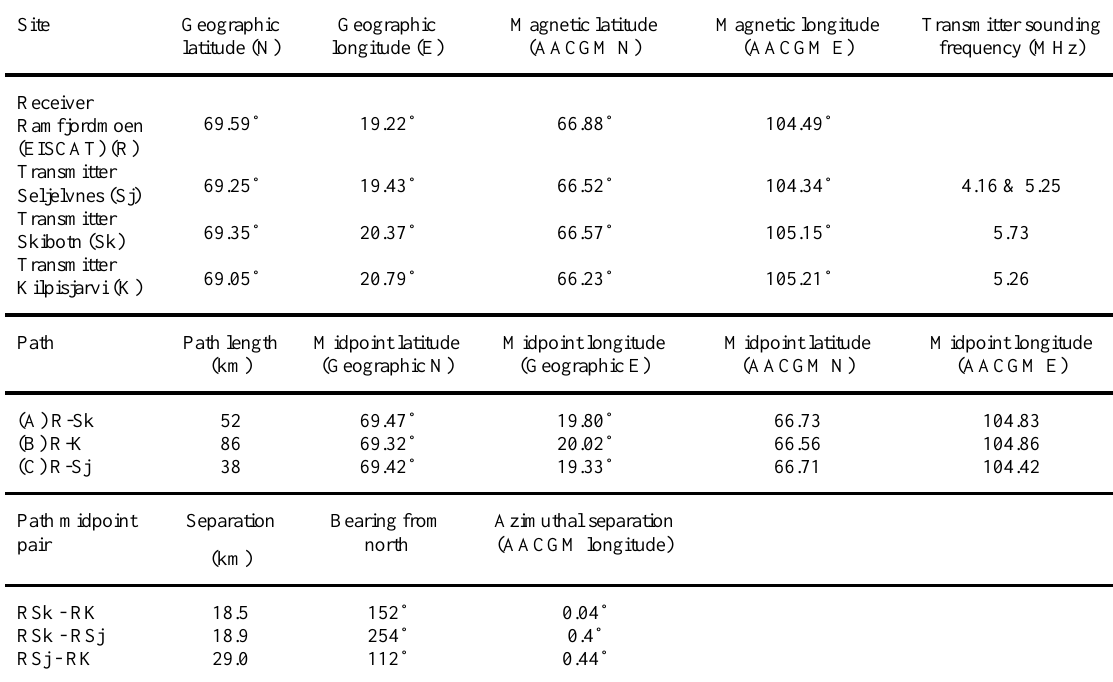
Table 1. Locations of the DOPE transmit, receive and reflection points and the transmit frequencies.